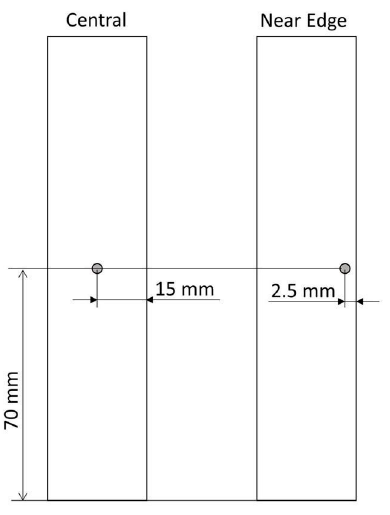
Figure 2. Impact Figure 2. Impact locations.